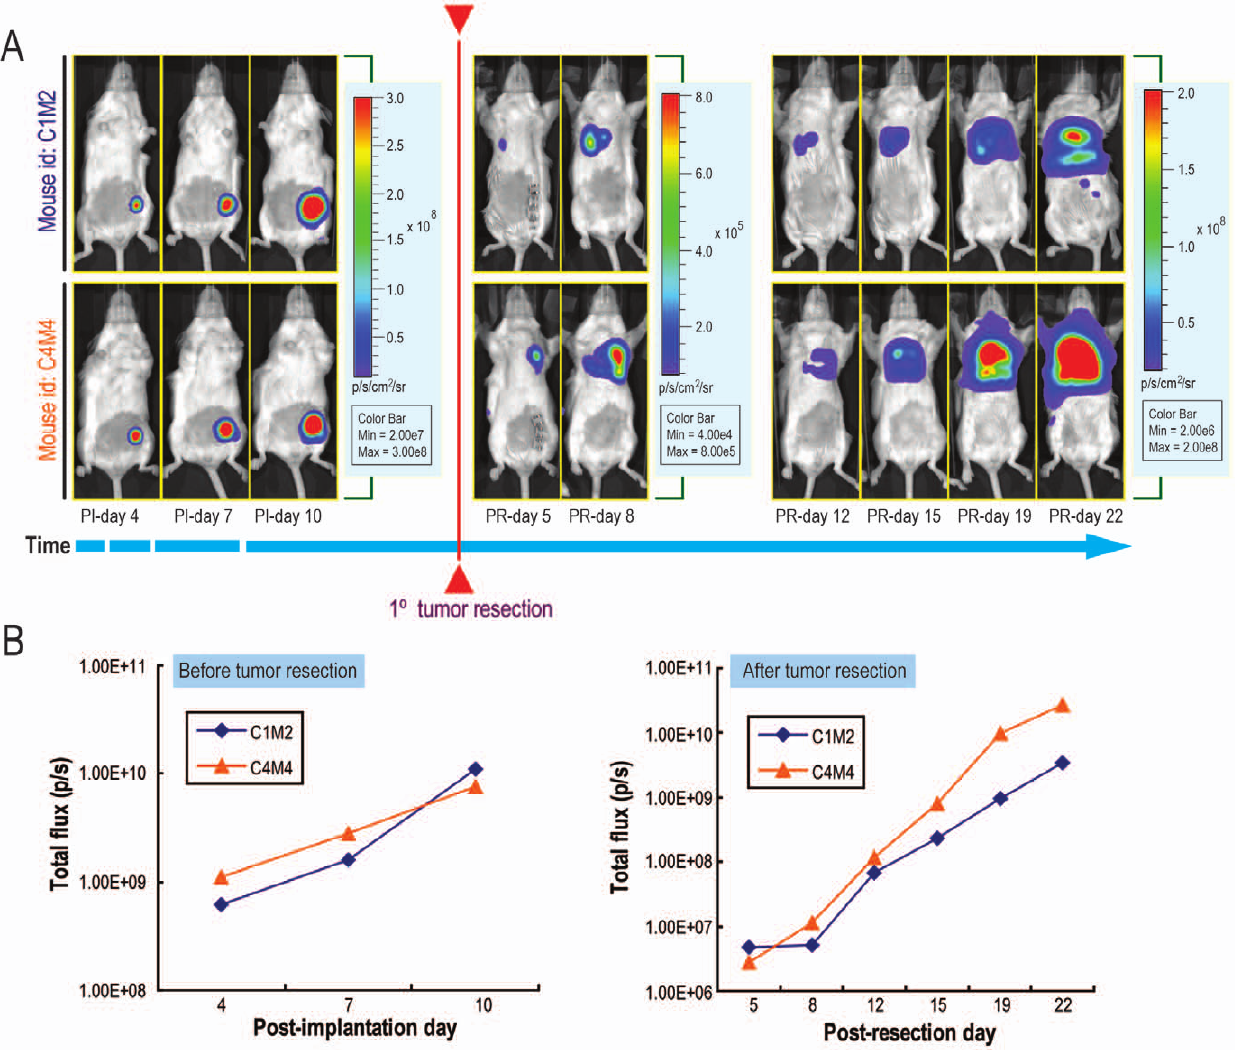
Figure 5. 4T1-luc2-1A4 tumor metastases in syngeneic Balb/c mice. (A) Metastases of 4T1-luc2-1A4 tumors in Balb/c mice. 5.0 6 10 4 cells were orthotopically implanted into mammary fat pads of the mice (n=16)[1]. Ventral Images were taken at three time points post-implantation (PI-days: 4, 7, 8). Primary tumors were resected at PI-day 10 and images were taken again at various post-resection time points (PR-days: 5, 8, 12, 15, 19, 22). Two representative mice (C1M2 and C4M4) are shown. The apparent decrease of the bioluminescence signals at PR-day 12 was due to the adjustment of the color bar scale (see panel B). Primary tumor resection time point is indicated by the red line separating the pre-and pot-resection images. (B) Plots of bioluminescence signals vs. time for mice C1M2 and C4M4. Whole body bioluminescence signals of mice C1M2 (blue lines) and C4M4 (orange lines) were quantitated and plotted in a logarithmic scale. Quantitations of bioluminescence signals before and after resection of the primary tumors are